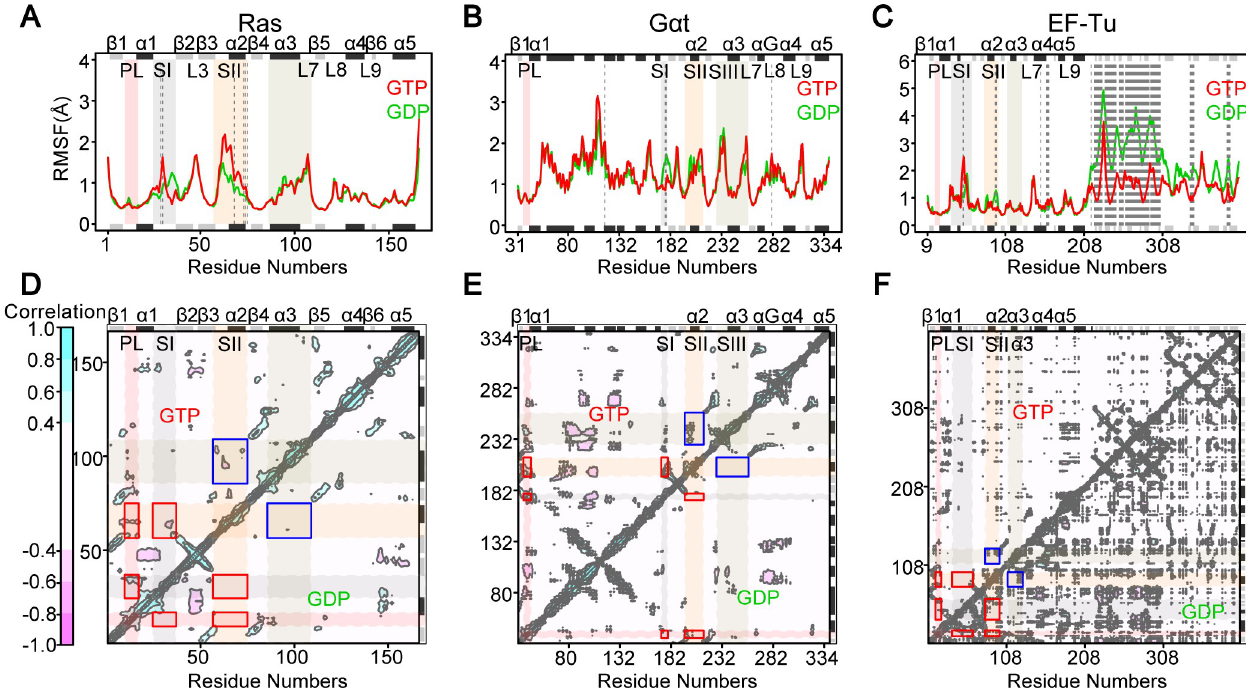
Fig 3. Nucleotide specific residue fluctuations and cross-correlations of atomic displacements from molecular dynamics simulations. ( A-C ) The ensemble averaged root-mean-square fluctuation (RMSF) reveals nucleotide dependent flexibilities that are consistent in the Ras-like domain of Ras ( A ), G α t ( B ) and EF-Tu ( C ). Residues with significant differences ( p -value < 0.01) between GTP and GDP bound states are highlighted with dashed lines. ( D-F ) The cross-correlations reveal stronger intra-lobe1 couplings between PL, SI and SII (red rectangles) and inter-lobe couplings between SII and SIII/ α 3 (blue rectangles) in the GTP-bound state (upper triangle) for both Ras ( D ) and G α t ( E ).